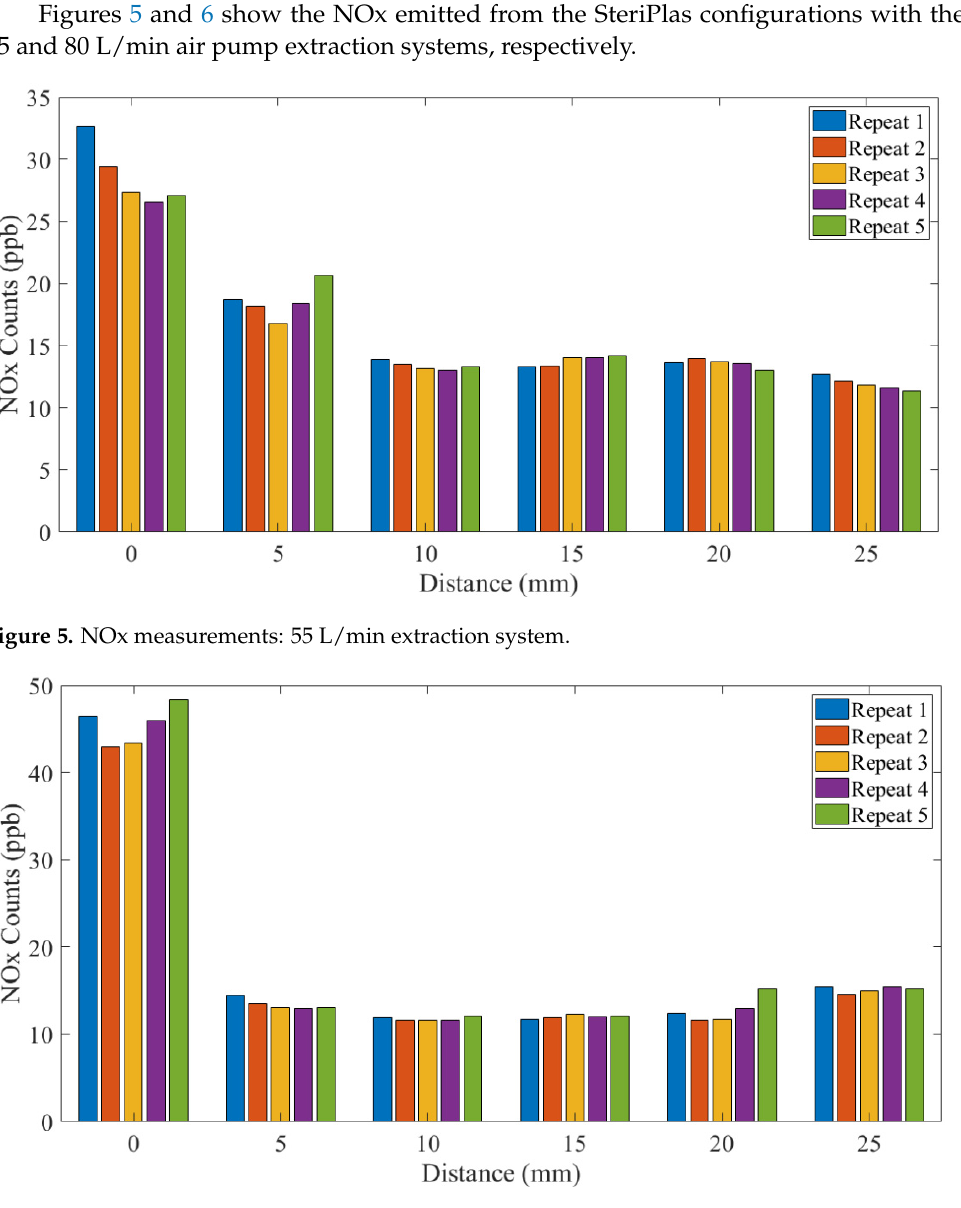
Figure 7. Ozone measurements: 55 L/min extraction system.